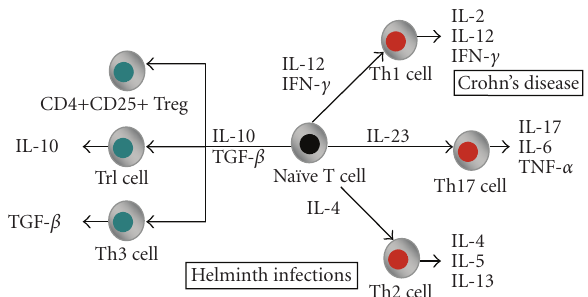
Figure 1: T-cell subsets . Na¨ıve CD4+ T cells are stimulated by antigen presenting cells and the cytokine environment to proliferate into a certain subset. There are three distinct e ff ector T-cell subsets (red): Th1, Th2, and Th17. CD4+ regulatory T-cells (green) can be subdivided in CD4+CD25+ Treg, Tr1, and Th3 cells. Crohn’s disease is characterized by Th1, Th17 inflammation, whereas helminths induce Th2 and regulatory T-cells (modified from [36,